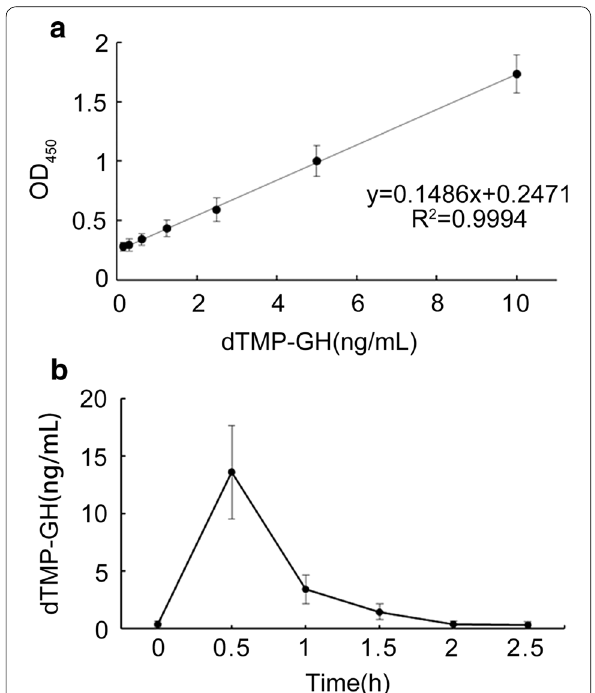
Fig. 5 Pharmacokinetics evaluation of dTMP-GH in rabbit. a the standard curve of dTMP-GH in rabbit. b concentration–time curve of dTMP-GH in rabbit serum after single intramuscular injection (100 μg/